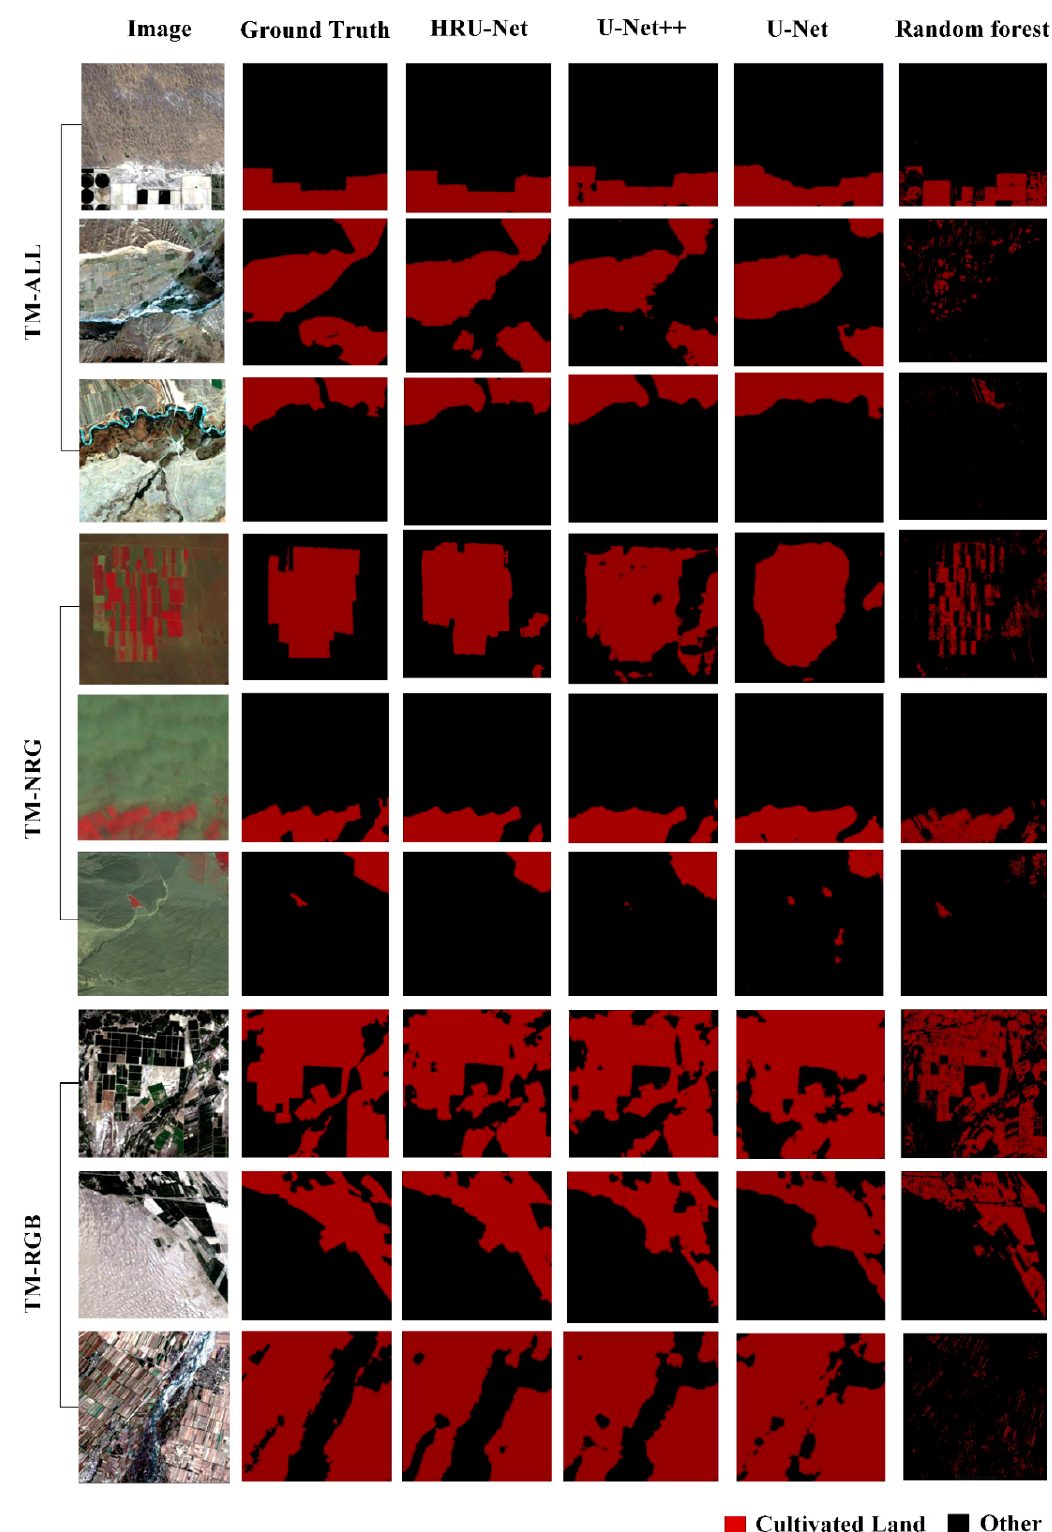
Figure 7. Selected results for the best RFU-Net, U-Net, and random forest models on all three datasets.